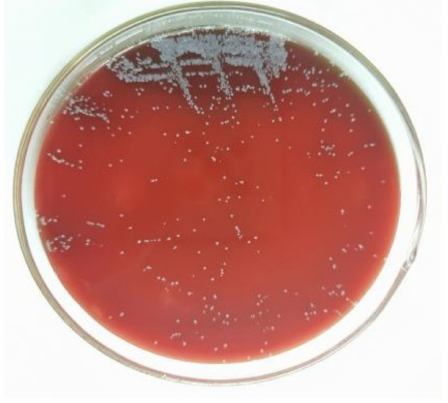
Figure 1. Purified bacterial colonies cultured on blood